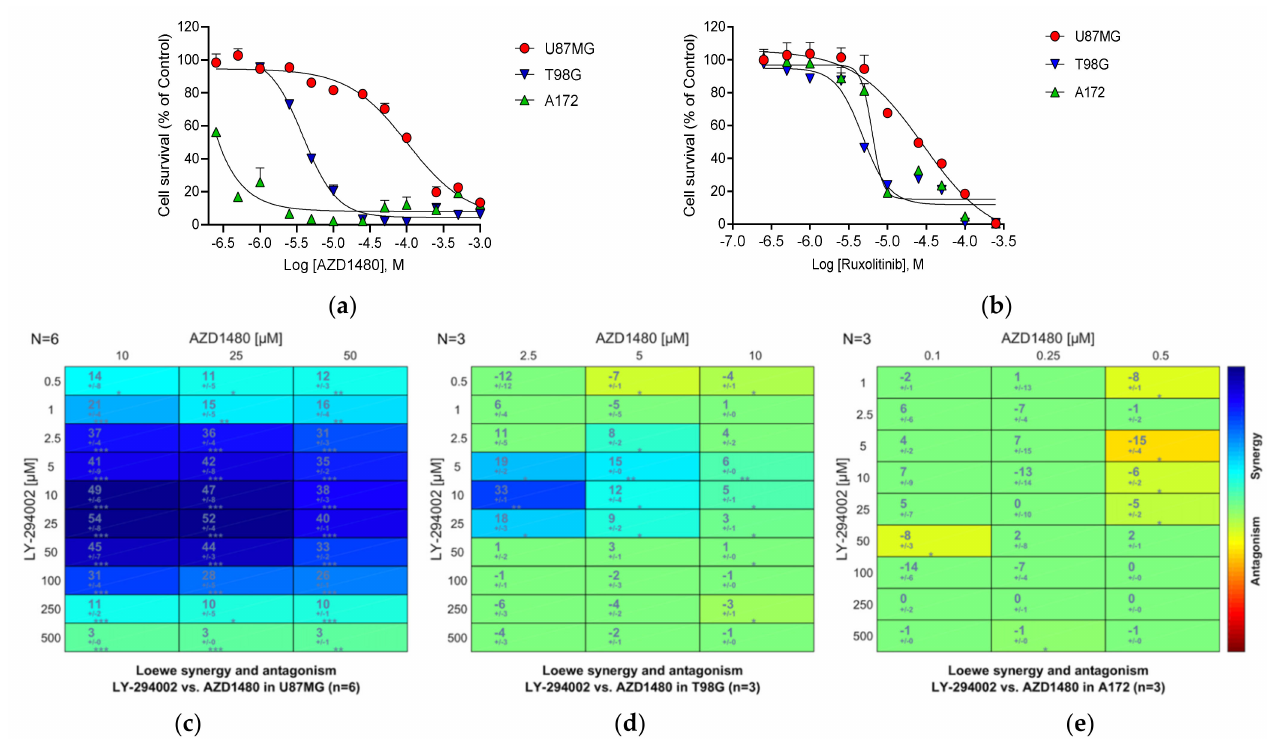
Figure 10. Anti-proliferative effects of JAK2 inhibitors on U87MG, A172 and T98G cells. ( a ) AZD1480; ( b ) Ruxolitinib. Data are presented as the mean ± standard error of the mean (SEM) ( n = 3–6). Panels ( c – e ) show Loewe synergy plots for the combination of AZD1480 and LY-294002 in U87MG, T98G, and A172 glioblastoma cells, respectively. U87MG cells showed pronounced synergy for this combination, with synergy scores rising to >50. Note: Asterisks indicate the significance of synergy scores obtained following a one-sample t -test (* p < 0.05; ** p < 0.001; *** p <